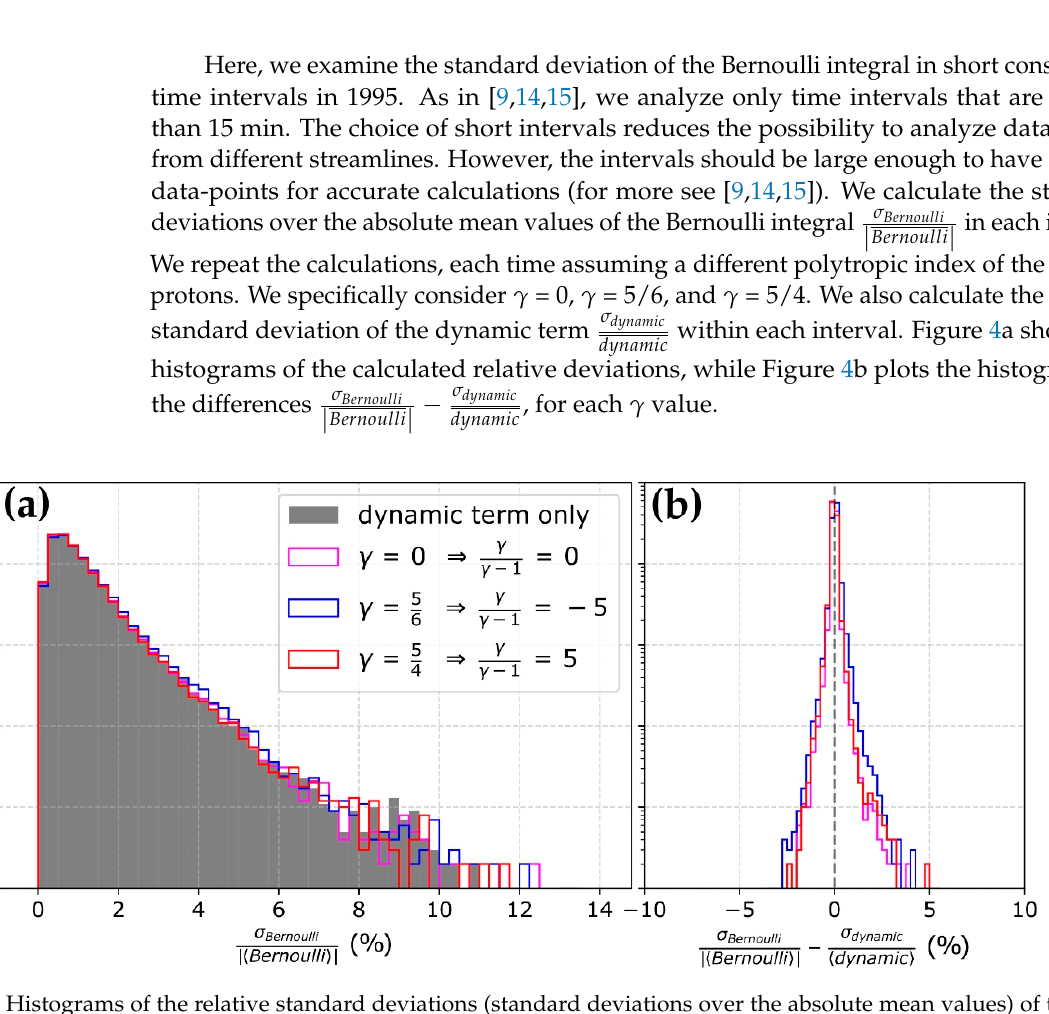
v 2 . ( b ) histograms 𝑣 (cid:2870) . ( b ) histograms of the 2 (cid:2870)